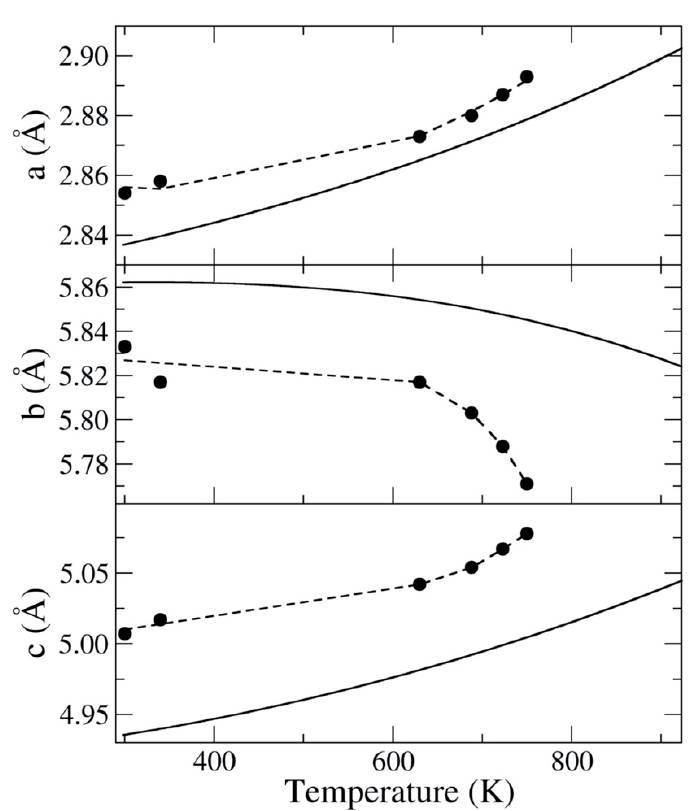
Figure 3. The temperature dependence of the a (top panel), b (middle panel), and c (bottom panel) lattice parameters (Å) in α uranium (solid circles). The dashed lines are guides to the eye only. The experimental behaviors [45] are shown as solid lines.